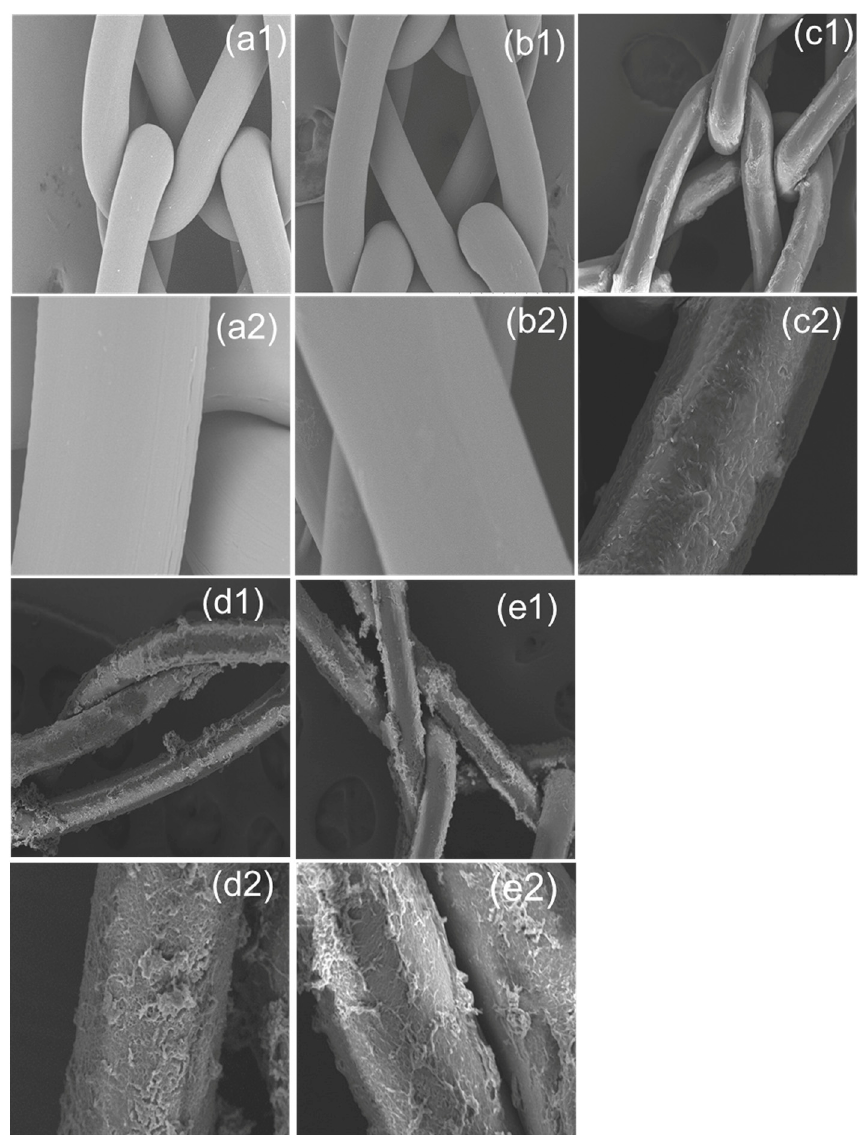
Figure 3. SEM micrographs; ( a1 , a2 ) PP control; ( b1 , b2 ) oxygen plasma treated; ( c1 , c2 ) HDI grafted PP-HDI-6; ( d1 , d2 ) HDI-CD-6; and ( e1 , e2 ) CD-TCL-6 (top row 200×, bottom row 1000×).